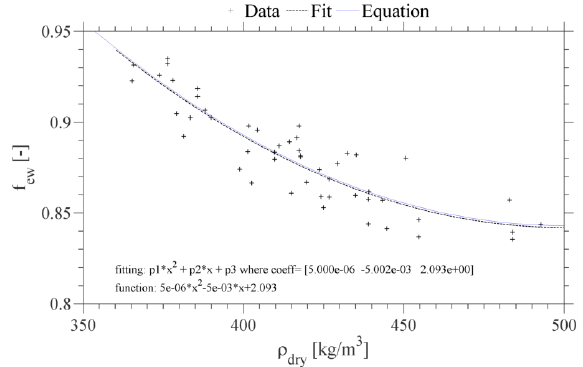
Figure 3. Dependence of the earlywood volume frac- tion on dry wood density [kg/m 3 ].